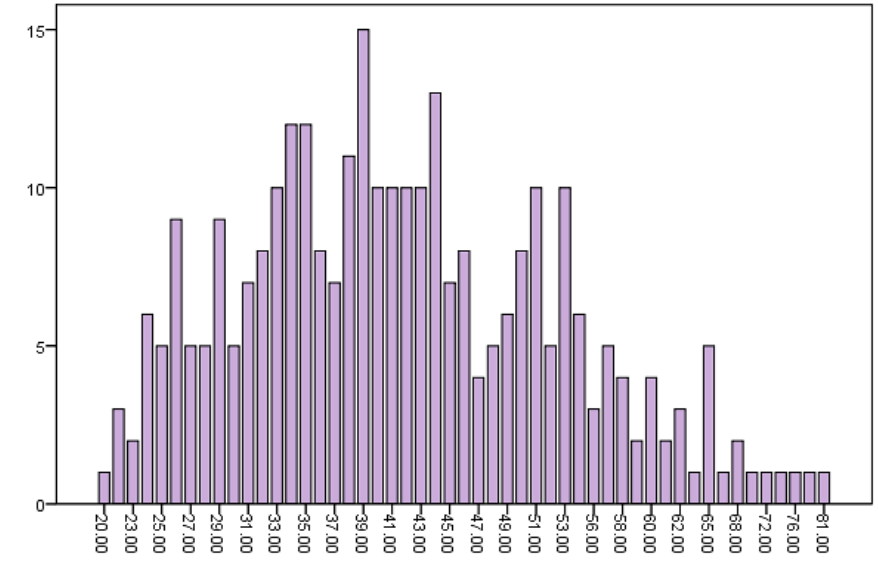
Figure 1. Distribution of students' internet addiction